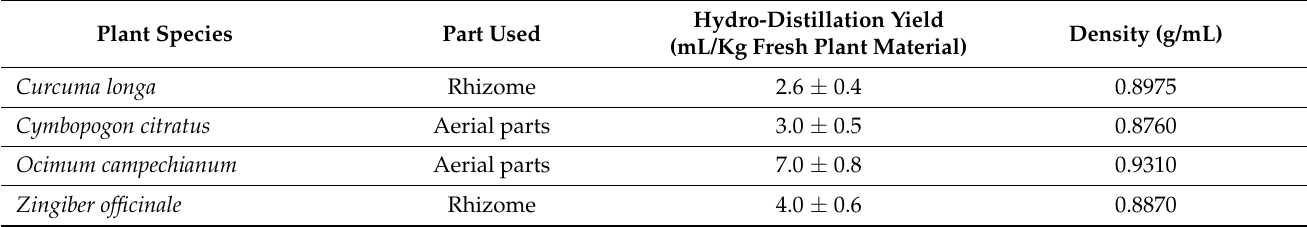
Table 1. Yields and density of Amazonian essential oils (EOs) obtained by steam distillation of Curcuma longa , Cymbopogon citratus , Ocimum campechianum , and Zingiber officinale fresh plant material. Hydro-Distillation Yield Plant Species Part Used Density (g/mL) (mL/Kg Fresh Plant Material) Curcuma longa Rhizome 2.6 ± 0.4 0.8975 Cymbopogon citratus Aerial parts 3.0 ± 0.5 0.8760 Ocimum campechianum Aerial parts 7.0 ± 0.8 0.9310 Zingiber officinale Rhizome 4.0 ±